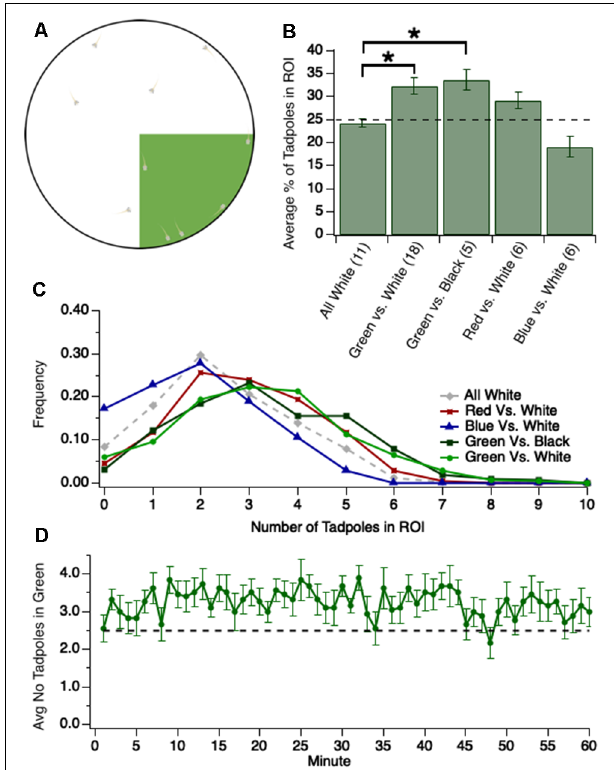
FIGURE 1 | Tadpoles spend significantly more time in the green region of test dish when green is pitted against either white (brighter than green) or black (darker than green). (A) Experimental design: 1/4th of the floor of the test dish, the region of interest (ROI), is colored either green (shown here), blue, or red. The colors are approximately equiluminant. Ten tadpoles are transferred into the dish and videotaped for either 1 h or 30 min as they swim freely around the dish, and videos are analyzed off-line. (B) Bar graph showing the average number of tadpoles residing for different colored ROIs, pitted against black or white (* p < 0.05). The dashed line represents the percentage of tadpoles expected to be in the ROI if no preference. (C) Normalized frequency (Y-axis) of observing a given number of tadpoles in a given ROI (X-axis). (D) Plot showing the average number of tadpoles (out of 10 total) in the green quadrant at each minute, across 60 min. Notice that the average strength of preference for the green quadrant is modest yet stable over time, and is established by minute 2 of the trial. The trace/function represents 18 trials. The dashed line represents the average number of tadpoles expected to be in the green quadrant, at any given point in time, if no